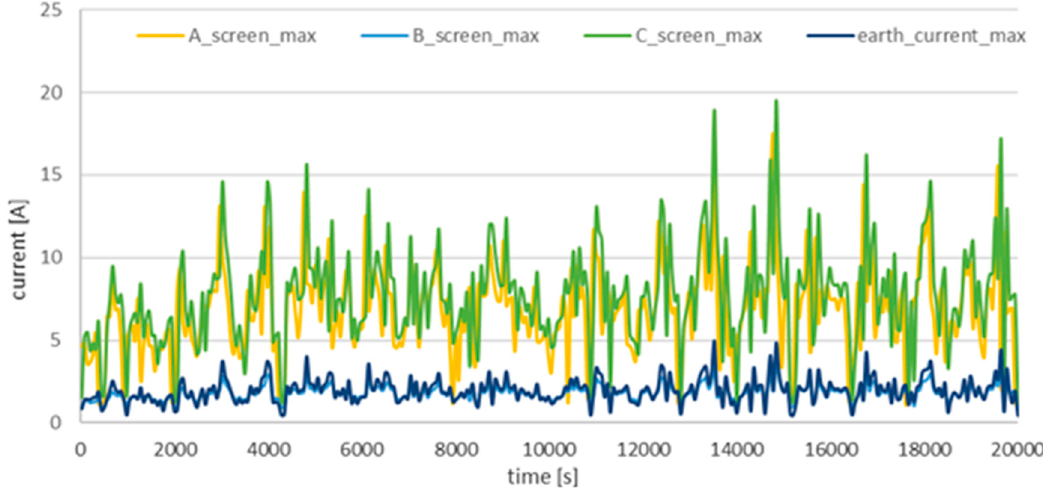
Figure 7. Measured cable screen current (max every 1 min).